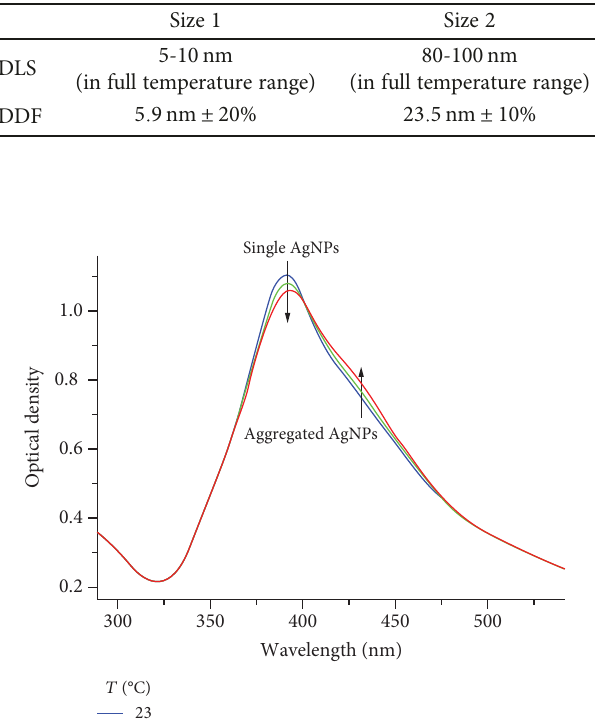
Table 1: Comparison of particle sizes, obtained from Dynamic Light Scattering data and distance distribution function calculations.